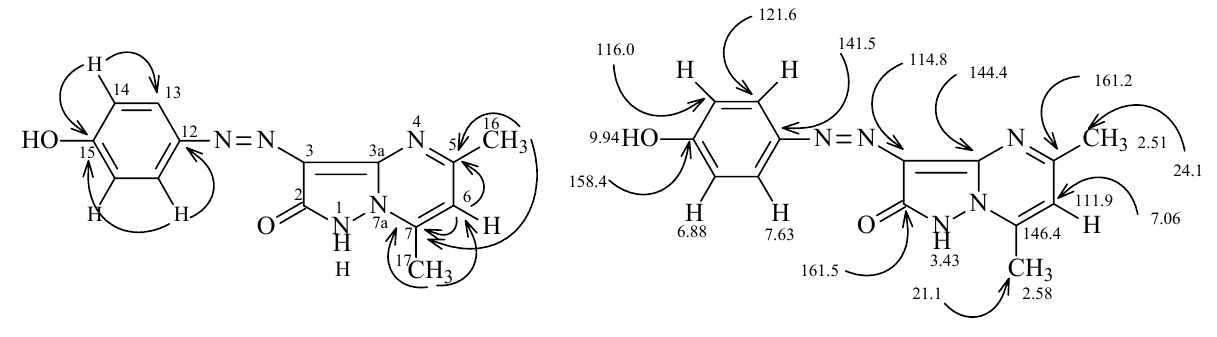
Figure 1. 1 H- and 13 C-NMR spectroscopy assignments of compound 7 .